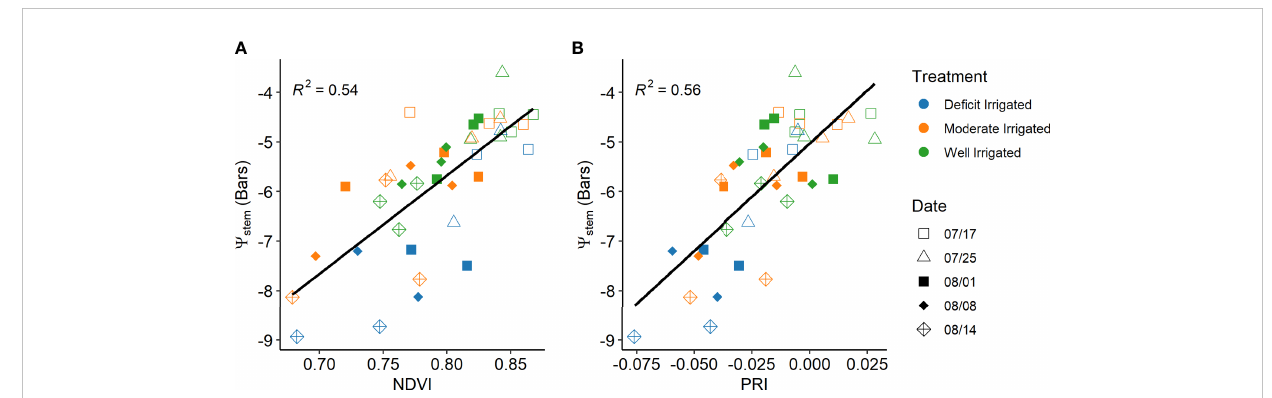
FIGURE 6 Relationships of the mid-day stem water potential ( y stem ) with concurrent vegetation indices from proximal sensors: (A) normalized difference vegetation index and (B) photochemical re fl ectance index after the tomato plants reached maximal canopy size and different irrigation treatments were applied.